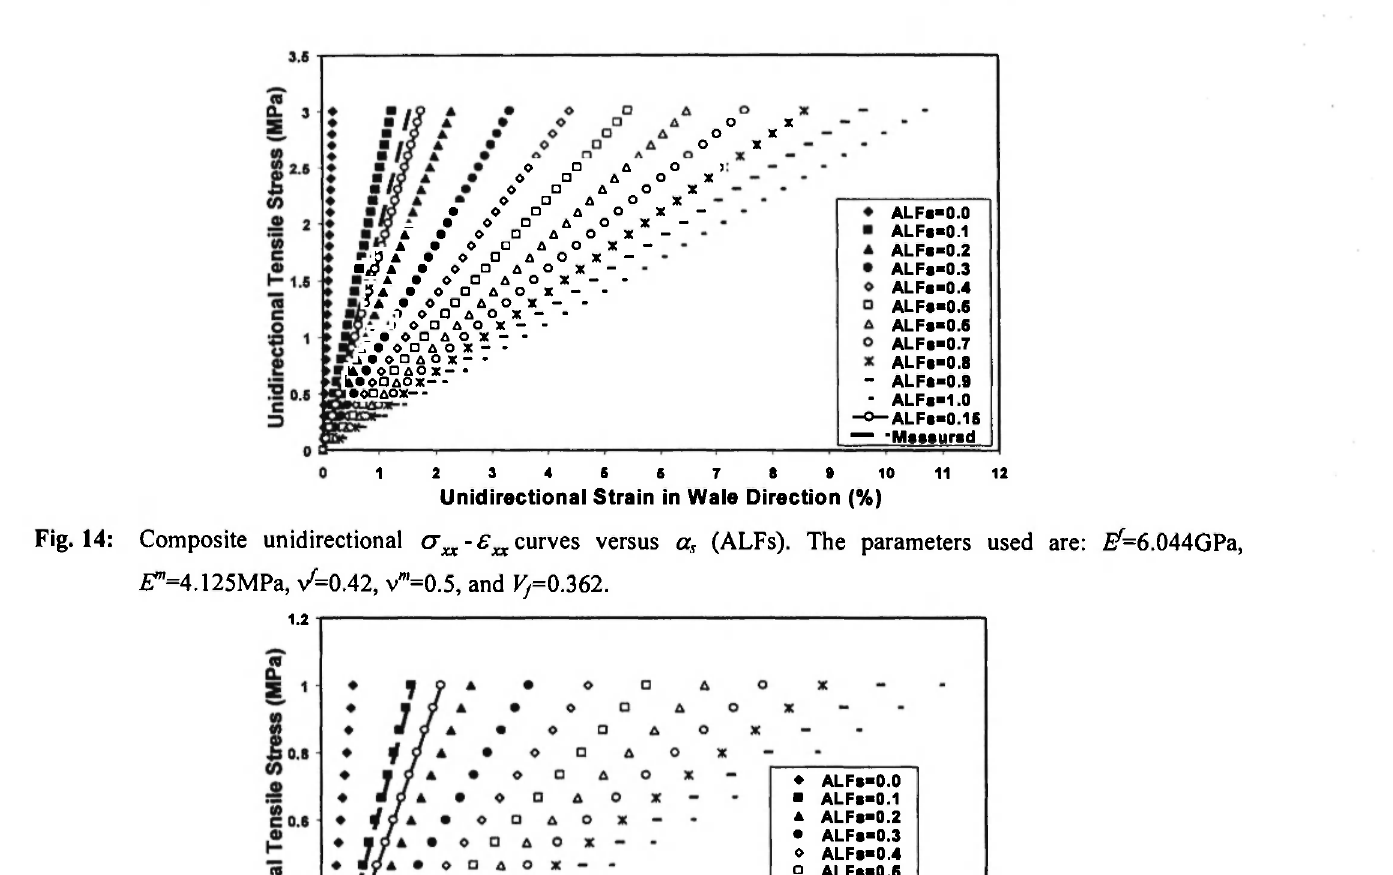
Fig. 15: Composite unidirectional σ - S yy curves versus a s (ALFs). The parameters used are: i/=6.044GPa, £"'=4.125MPa, \/=0.42, v m =0.5, and V,= 0.354.